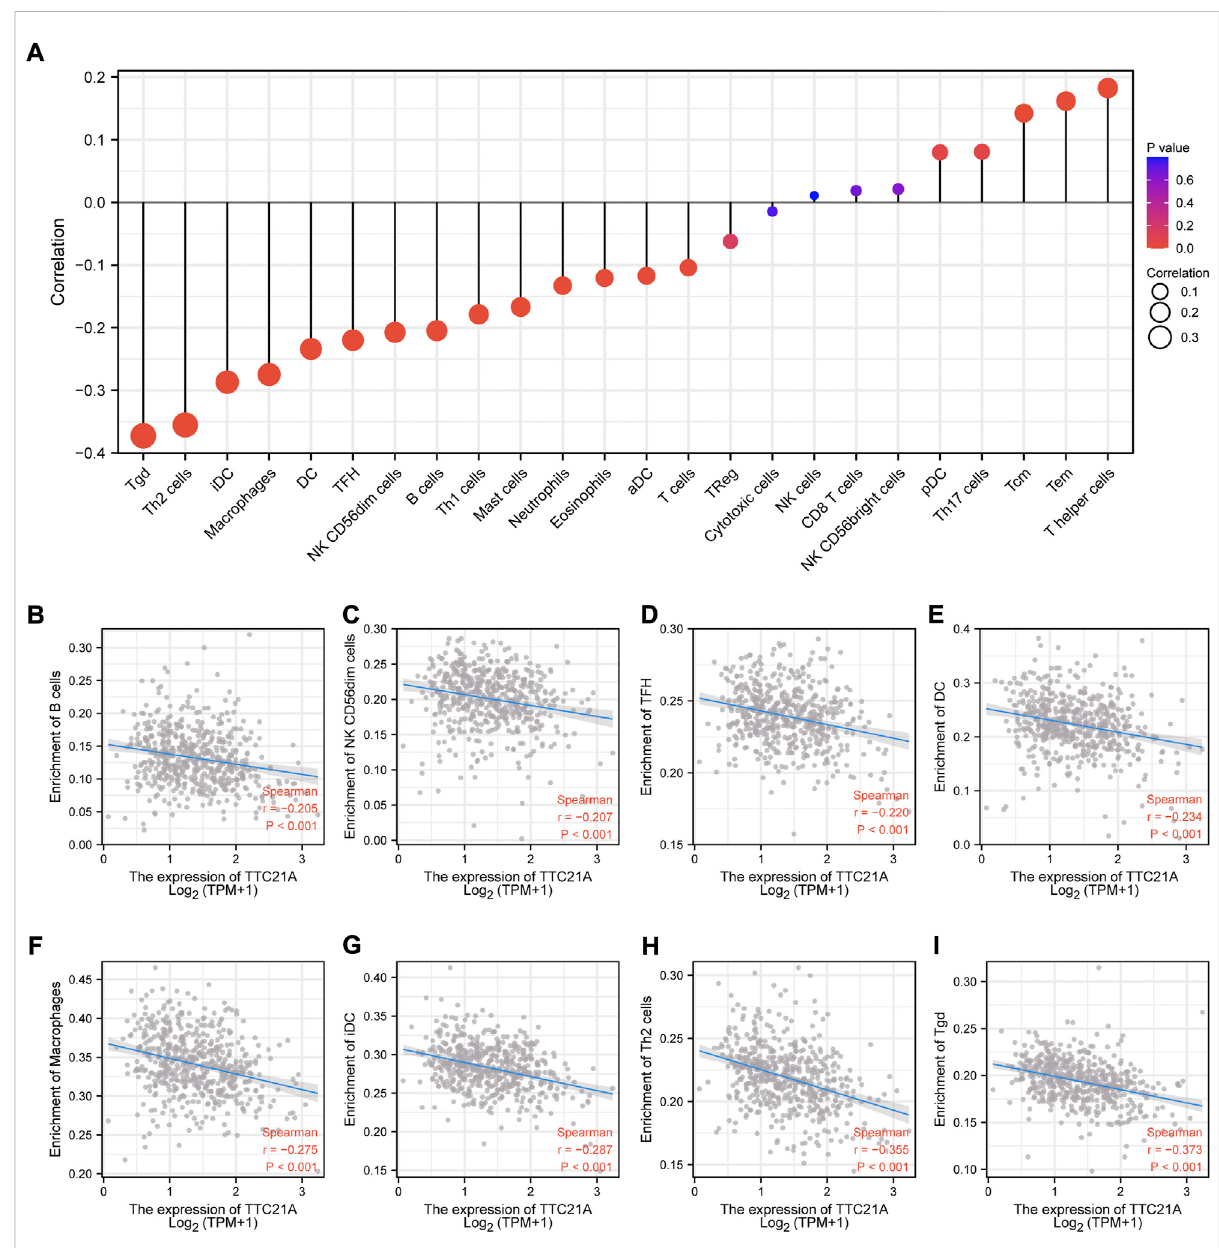
FIGURE 7 Association of TTC21A with immune in fi ltration. (A) Association of TTC21A with immune in fi ltration (Tem T effector memory, Tcm T central memory, Th helper T cells, pDC plasmacytoid DC, NK natural killer, Treg regulatory T cells, aDC activated DC, TFH T follicular helper, DC dendritic cells, iDC immature DC, Tgd T gamma delta). (B – I) TTC21A was negatively correlated with in fi ltration of B cells, NK CD56dim cells, TFH, DC, macrophages, iDC, Th2 cells and